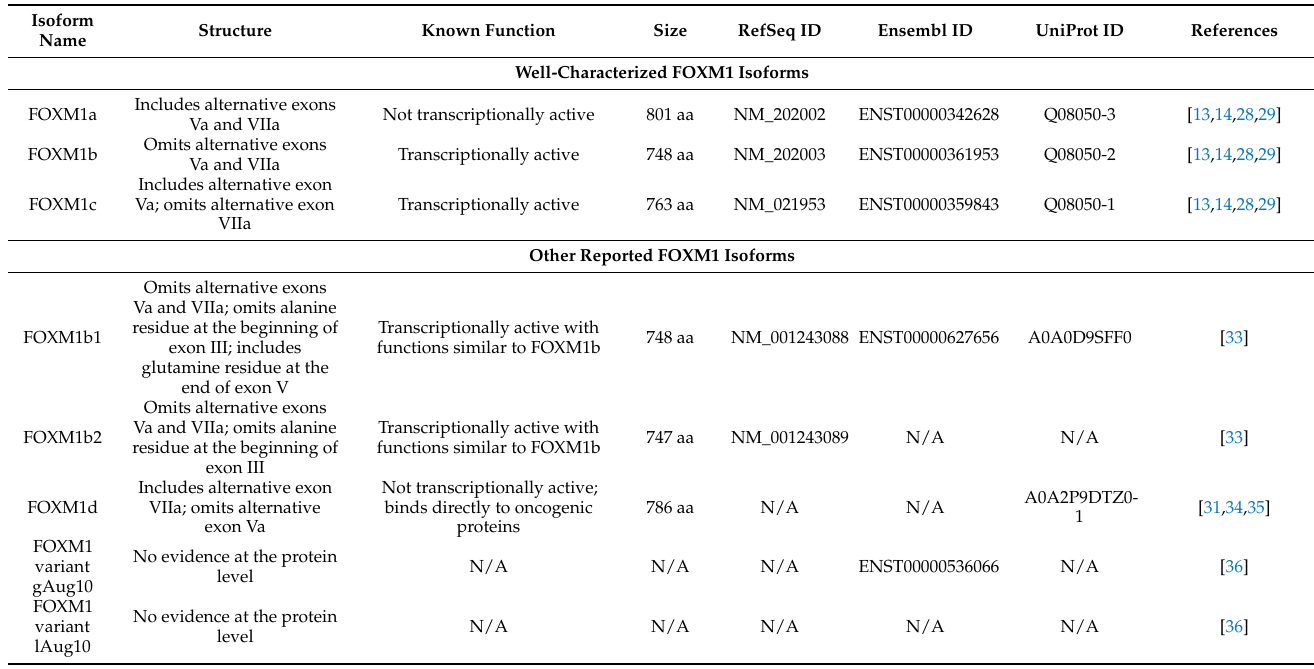
Table 1. FOXM1 isoforms and